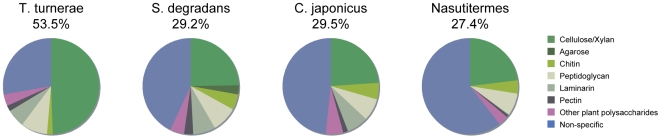
Prevalence of GH domains as a function of substrate specificity.The genome of T. turnerae contains a larger proportion of glycoside hydrolase (GH) domains with specificity for major wood components (cellulose, xylan, mannans, and rhamnogalactans) than do other compared genomes and metagenomes. GH domains are sorted by known substrate specificity and presented as a fraction of the total number of GH domains per genome. Substrate specificities are coded as follows: green = cellulose/xylan, (GH families 5, 6, 8, 9, 10, 11, 12, 44, 45, 51, 52, 62, and 74), dark green = agarose (GH families 50 and 86), light green = chitin (GH families 18, 19, and 20), light grey = peptidoglycan (GH families 28 and 105), dark grey = laminarin (GH families 16 and 81), black = pectin (GH families 28 and 105), purple = other woody plant cell wall polysaccharides (GH families 26, 53, and 67) and blue = GH domains with other specificities or specificities not uniquely predicted by family designation. Proportions are expressed as a fraction of the total number of GH domains found in the genomes of Teredinibacter turnerae (101), Saccharophagus degradans (130), Cellvibrio japonicus (122), and Nasutitermes termite hindgut metagenome community (704) respectively. The fraction of total GH domains with specificity toward cellulose and xylan is indicated below each species name.